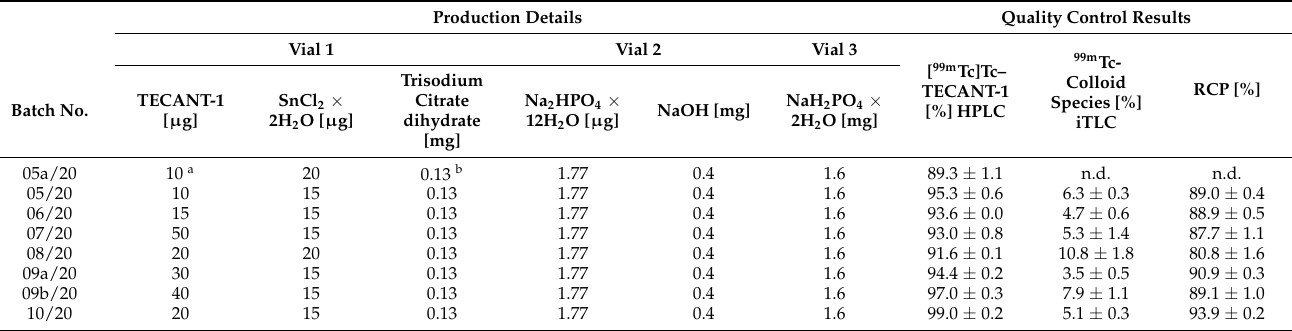
Table 4. Kit composition of development batches and radiochemical purity of initial radiolabelling